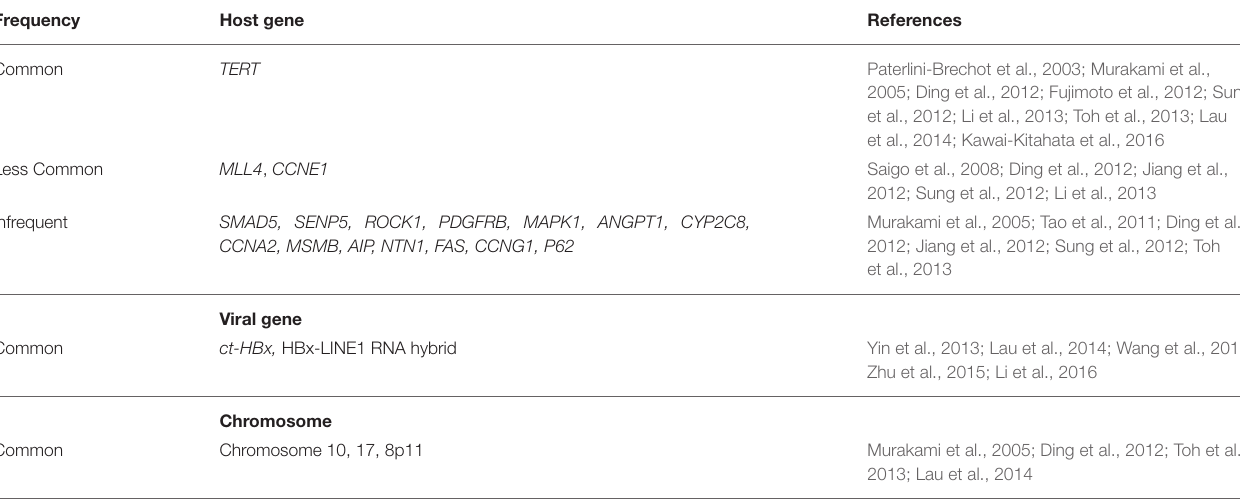
TABLE 3 | HBV integration into host genes in HCC tissues from next generation sequencing